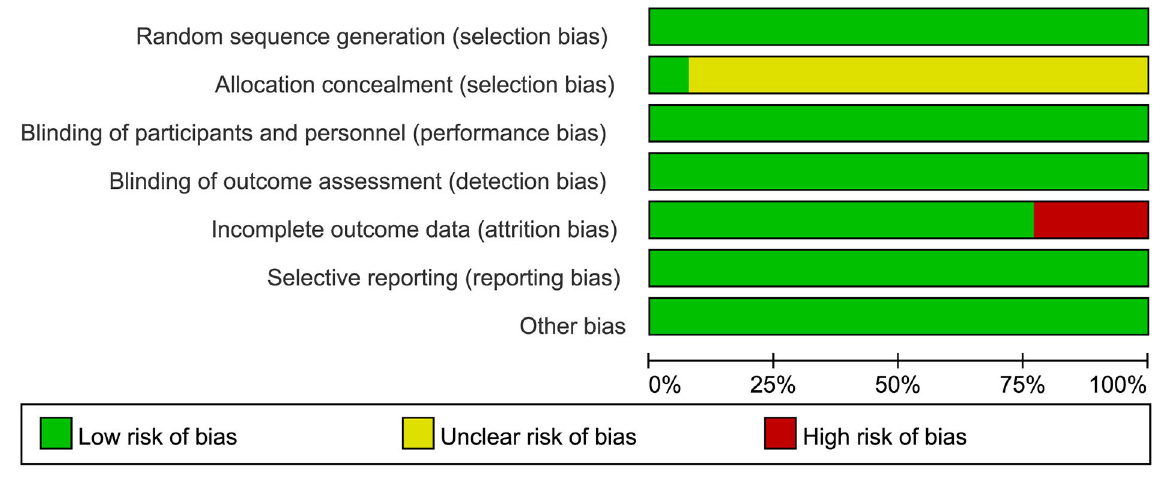
FIGURE3 Quality of the included RCTs assessed by Cochrane Risk of bias graph.